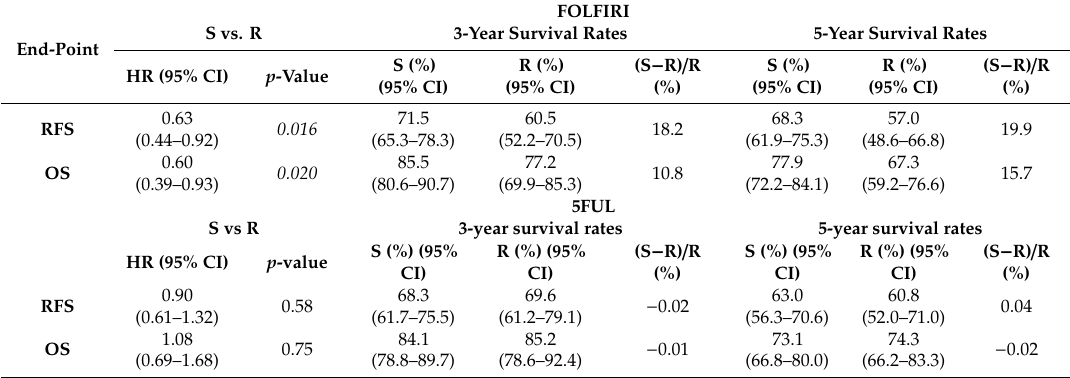
Table 3. Summary of patient survival rates by treatment and biomarker group (R: resistant, S: sensitive) at 3 and 5 years, respectively. The relative benefit is denoted by (S − R) /